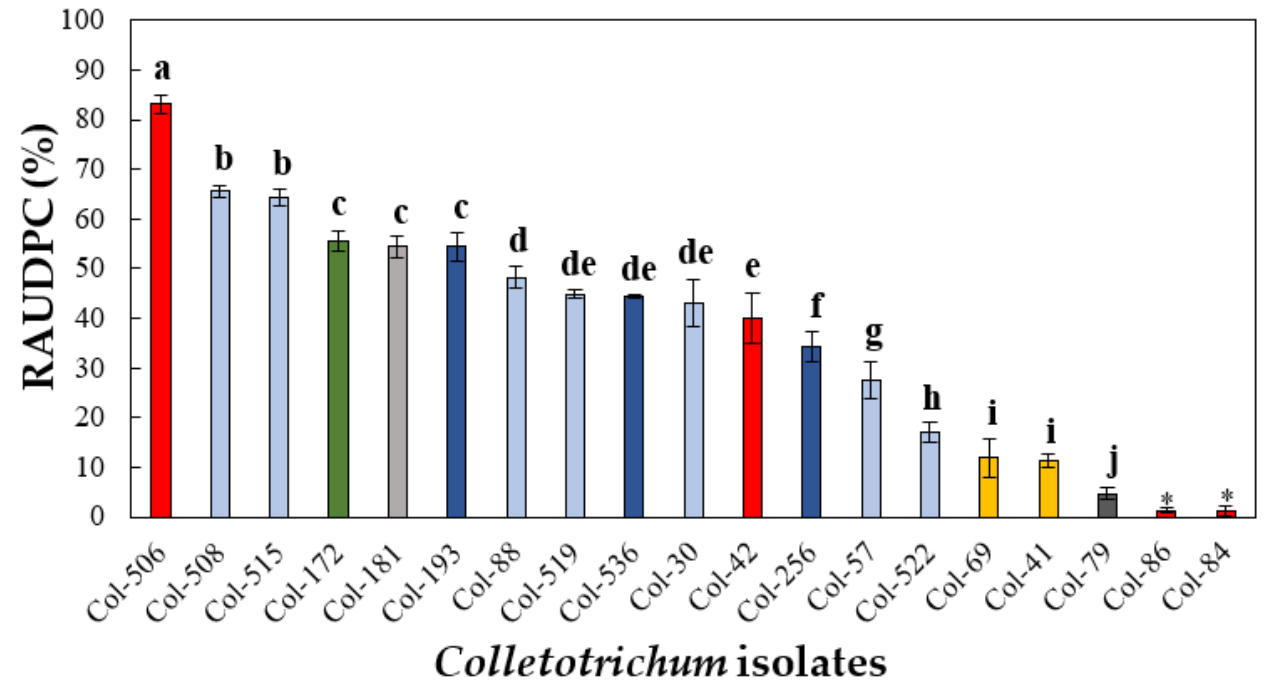
Figure 7. Relative area under the disease progression curve (RAUDPC) on the fruits of olive cv. Hojiblanca inoculated with the following isolates: C. acutatum (dark-blue columns) from olives (Col-193 and Col-256) and almonds (Col-536); C. fioriniae (green column) from olives (Col-172); C. gloeosporioides (yellow columns) from olives (Col-41) and sweet oranges (Col-69); C. godetiae (light-blue columns) from olives (Col-30, Col-57, Col-88, Col-508, Col-515, and Col-519) and almonds (Col-522); C. kasrstii (dark-gray column) from sweet oranges (Col-79), C. nymphaeae (red column) from olives (Col-42 and Col-506) and strawberries (Col-84 and Col-86), and C. siamense (light-gray column) from olives (Col-181). Columns are the means of two independent sets (experiments) of three replicated (humid chambers) with 20 fruits per humid chamber. Vertical bars are the standard error of the means. Columns with the same letter do not differ significantly according to Tukey’s HSD test at p = 0.05. * Isolates non-pathogenic to olives.